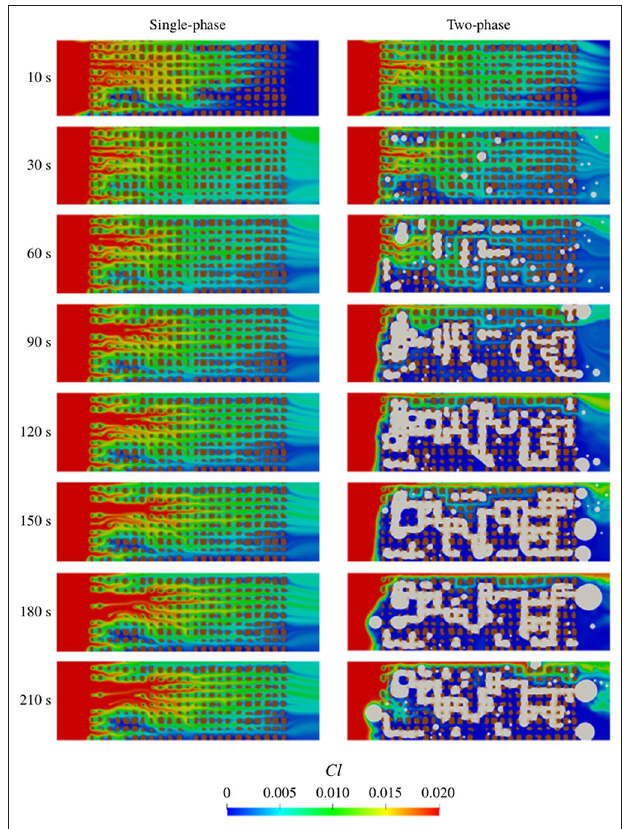
FIGURE 13 | Evolution of a porous medium during the injection of acid. The color map corresponds to the concentration of acid in the domain. Solid grains are depicted in brown. (Left) Under single-phase flow conditions, the acid penetrates the domain and dissolves the solid grains producing wormholes. (Right) The mineral dissolution generates CO 2 gas that occupies the pore space, limits the dissolution process and prevents the development of wormholes (Reprinted with permission from Soulaine et al., 2018, Copyright Cambridge University Press 2018).